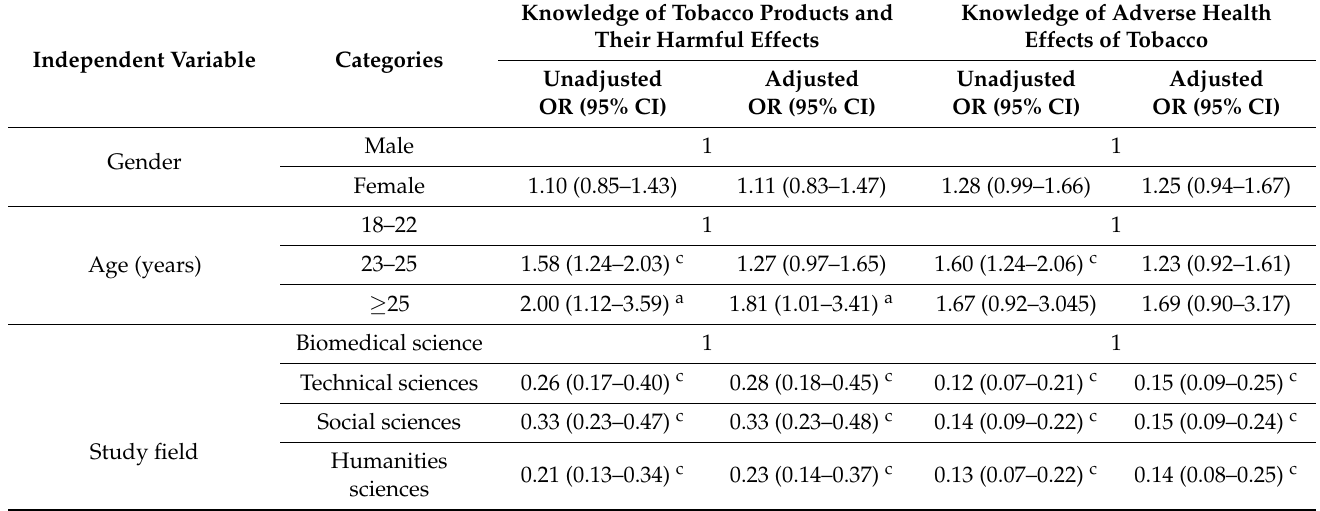
Table 4. Unadjusted and adjusted odds ratios for the associations of participants’ characteristics with knowledge of tobacco products and their harmful effects and knowledge of adverse health effects of